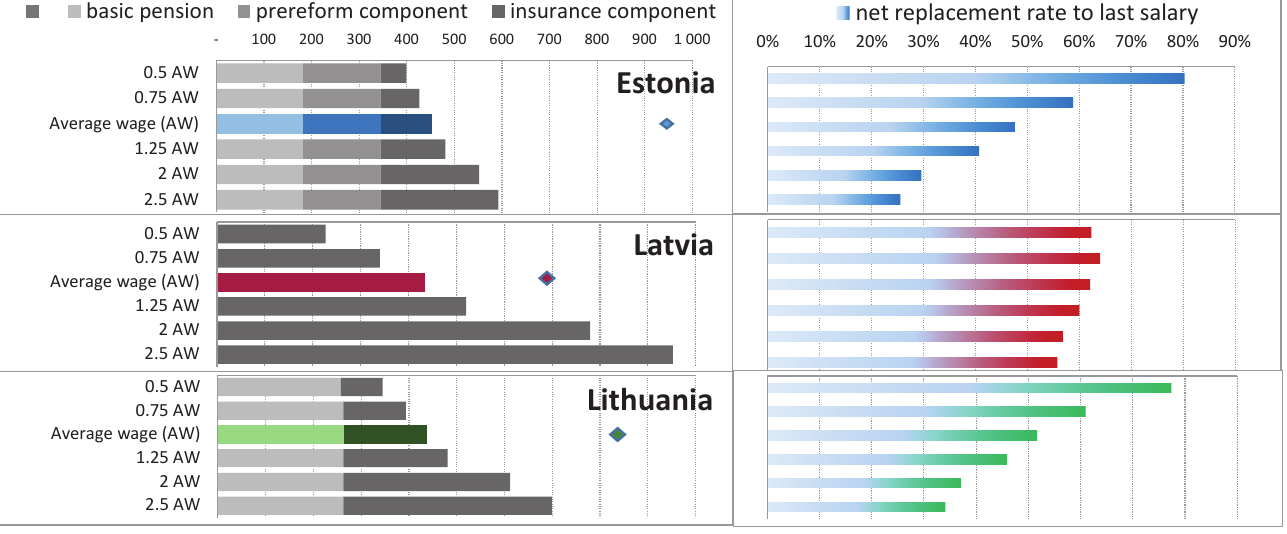
Fig. 1. Theoretical pensions and replacement rates.